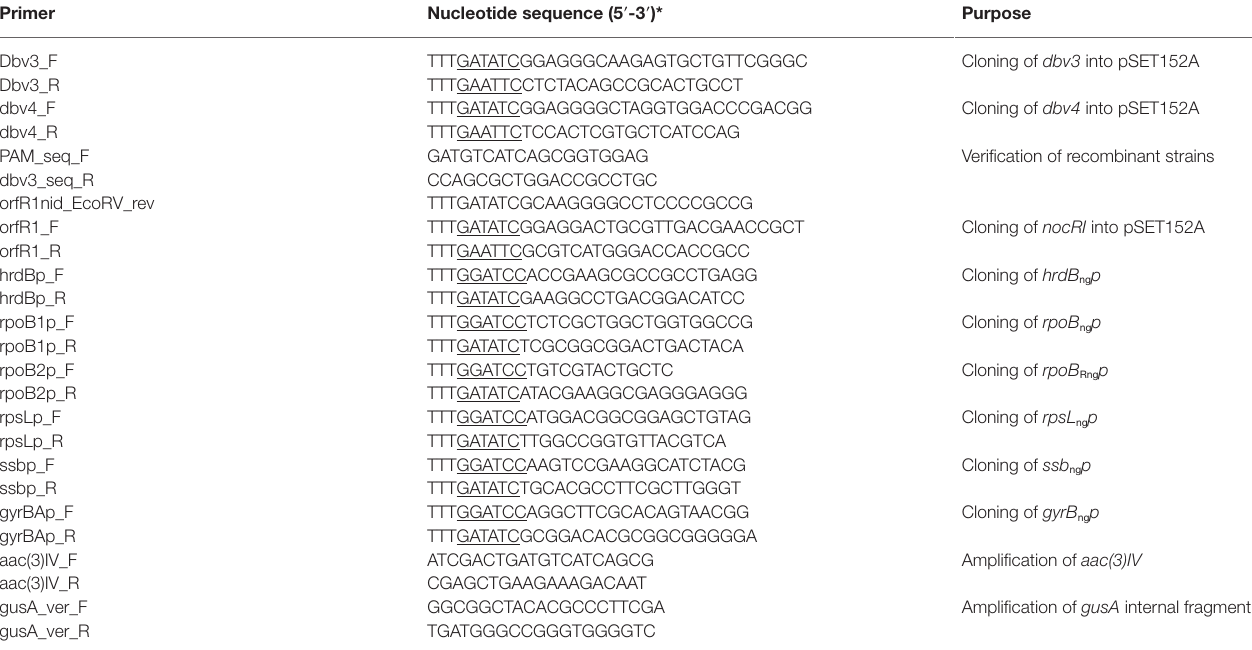
TABLE 2 | Oligonucleotide primers used in this work. Primer Nucleotide sequence (5 ′ -3 ′